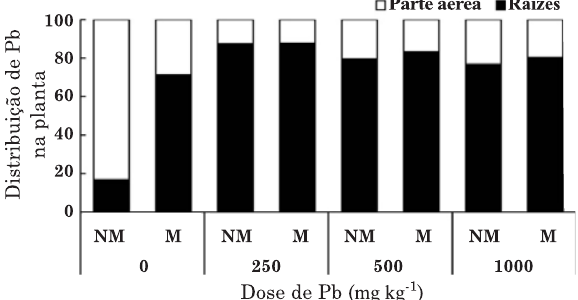
Figura 13. Distribuição de Pb nas raízes e órgãos aéreos de plantas de Stizolobium aterrimum não micorrizadas (NM) e micorrizadas